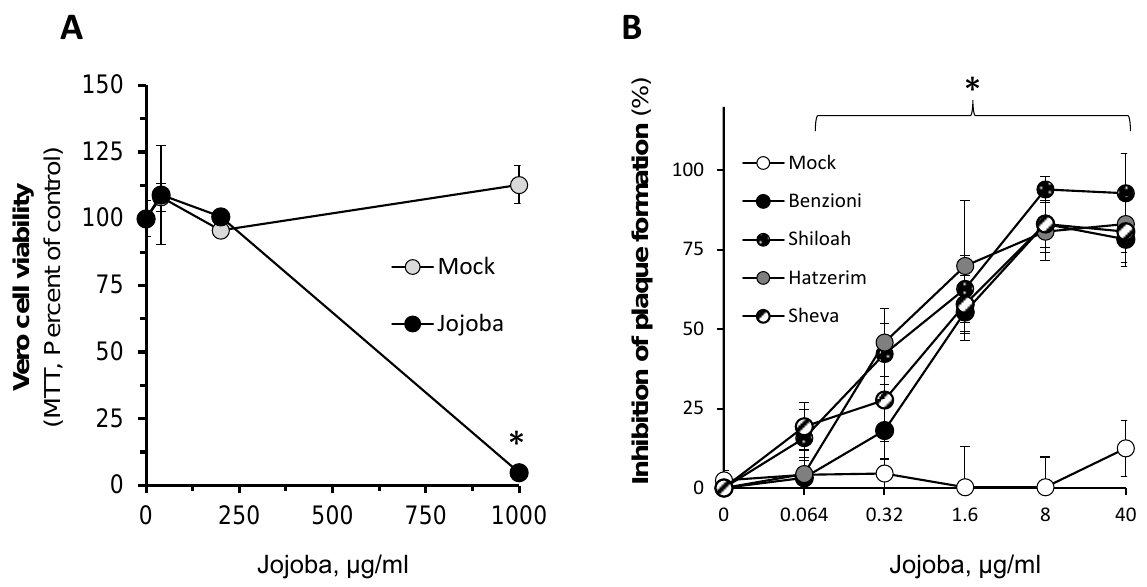
Figure 2. The impact of Jojoba wax on HSV-1 growth. Jojoba wax or vehicle (mock) were added in increasing dilutions to Vero cells. ( A ) Viability was determined by MTT. Mean ± SEM; n = 3; * p < 0.05 in comparison to the naïve control. ( B ) Dose-response analysis of Jojoba cultivars Benzioni, Shiloah, Hatzerim, and Sheva wax on plaque formation in HSV-1 infected Vero cells was performed as written in the “materials and methods” section. At 40 µg/mL Jojoba, 0.0015% of the surfactant was used . Mean ± SEM; n = 3; * p < 0.05 in comparison to the infected control. Table 1. Chemical composition of Jojoba wax. Benzioni, Shiloah, Hatzerim and Sheva, as well as commercial batches (JD1– 4) used in Figure 1.